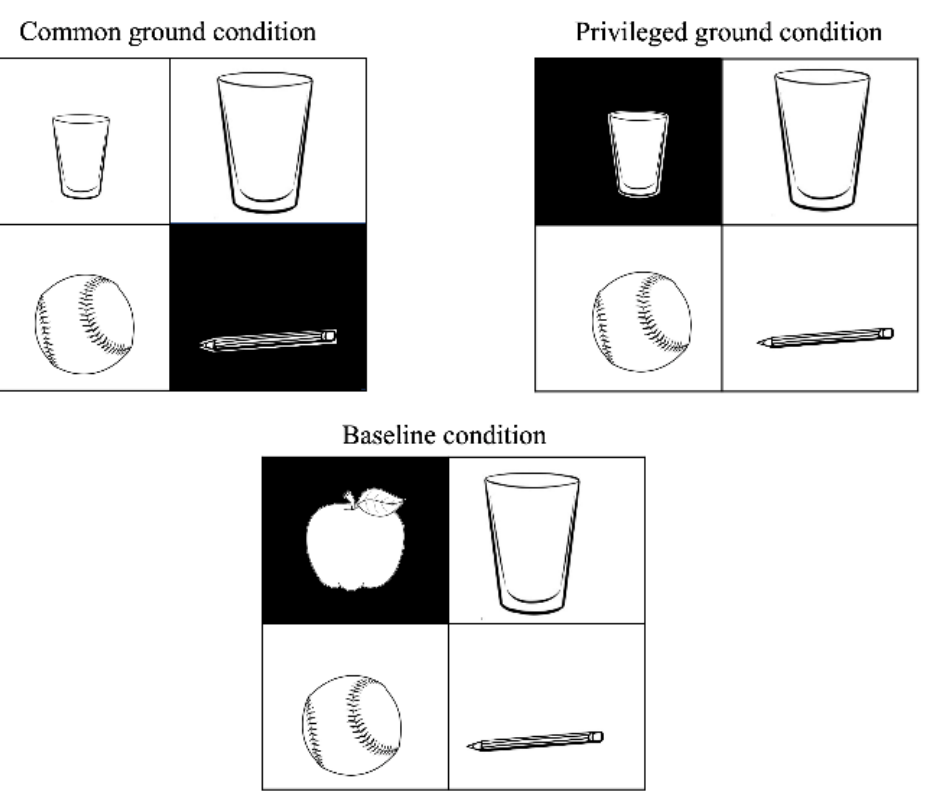
Figure 4. Sample displays for the three conditions tested in [26] (Permission pre-granted according to STM guideline). Shading denotes the wooden partition blocking the object from the speaker’s